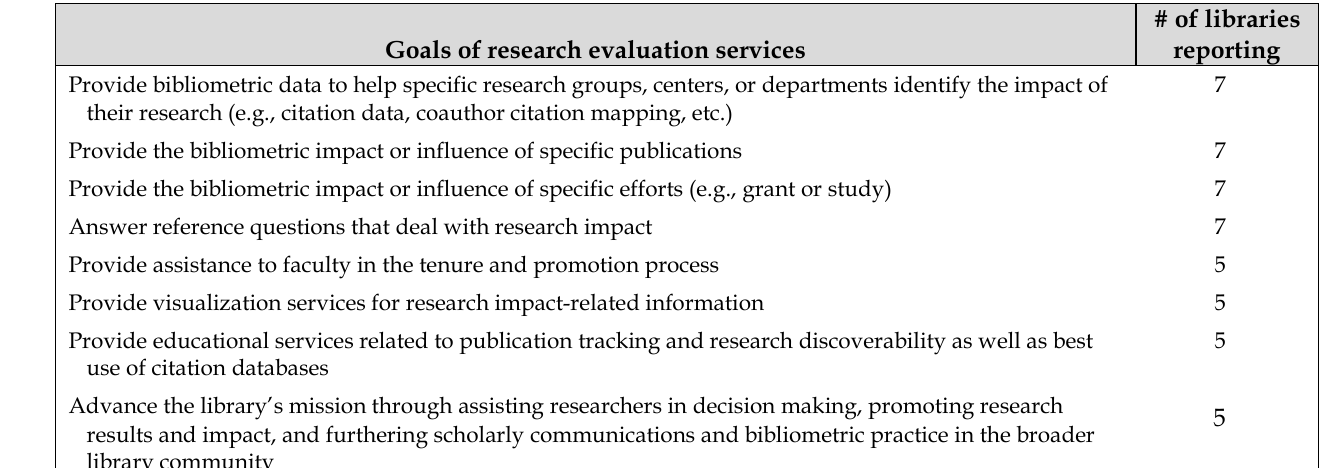
Table 3 Top reported goals of research evaluation